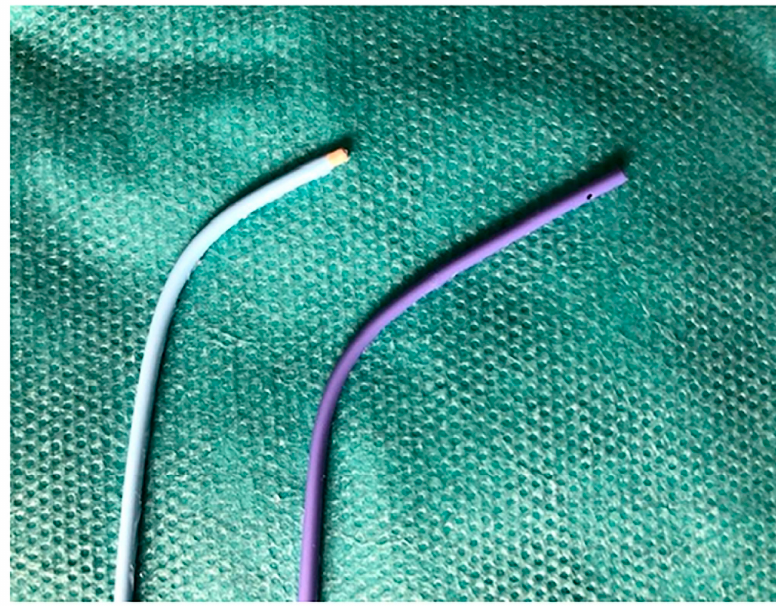
Figure 21. Multipurpose catheters (MP). Blue: MP-A1 (end-hole). Purple: MP-A2 (end-hole + side- holes).